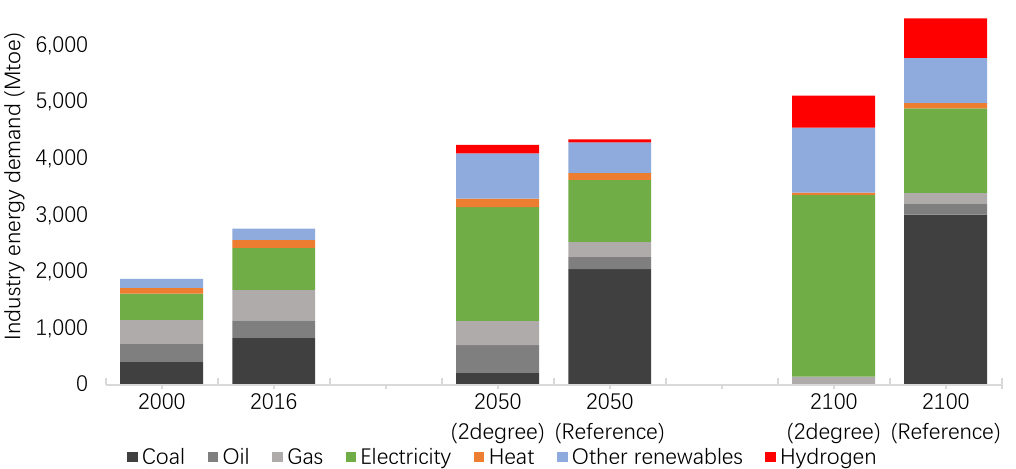
Figure 4. The evaluated regional and global industrial energy consumption per capita estimation from S-curve model.